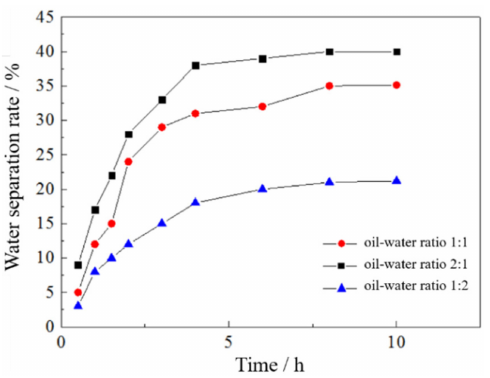
Figure 14. Change of the water release rate with the oil–water ratio.